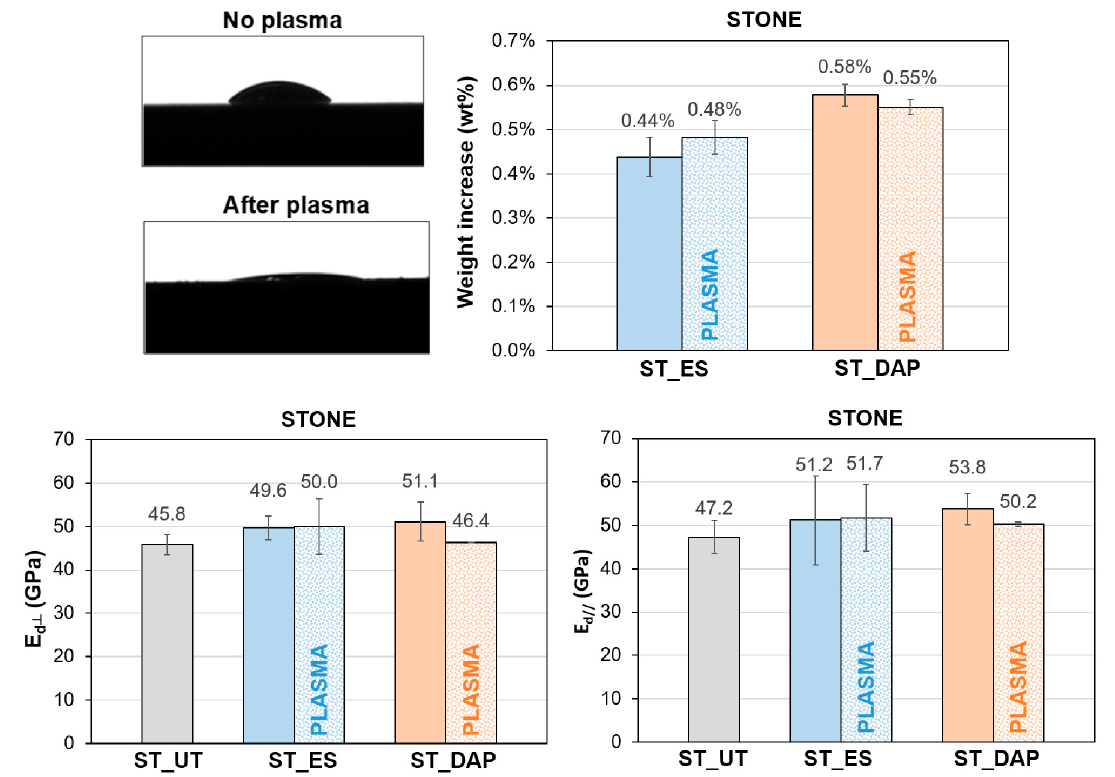
Figure 14. Effects of pre-treatment by plasma on the static contact angle of untreated stone (“ST_UT”) specimens, weight increase of the stone specimens (“ST”) at the end of the treatment application, and dynamic elastic modulus ( E d ) of untreated (“UT”) and treated (“ES” and “DAP”) stone specimens (“ST”), without (solid bars) and with (dotted bars) pre-treatment by plasma, in the directions perpendicular and parallel to the plane of the slab.